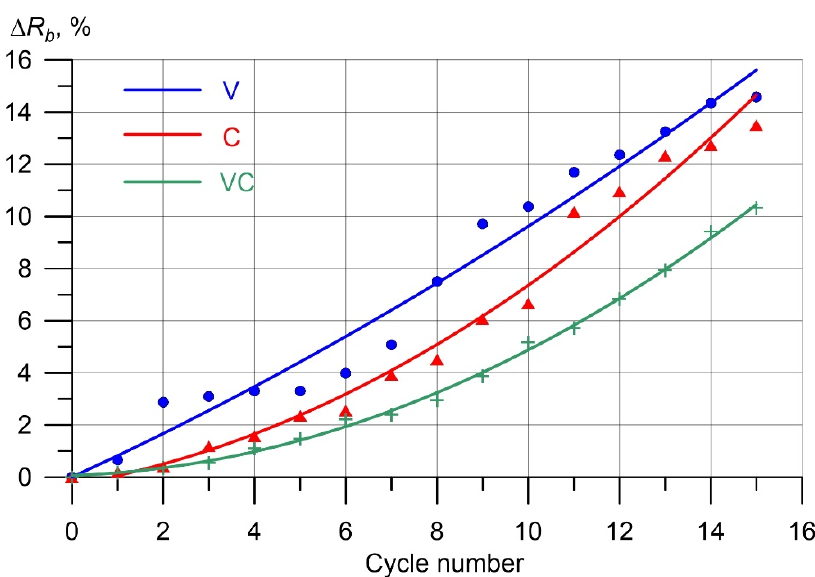
Figure 6. Compressive strength loss of vibrated (V), centrifuged (C), and vibrocentrifuged (VC) concretes depending on the number of freeze and thaw cycles.